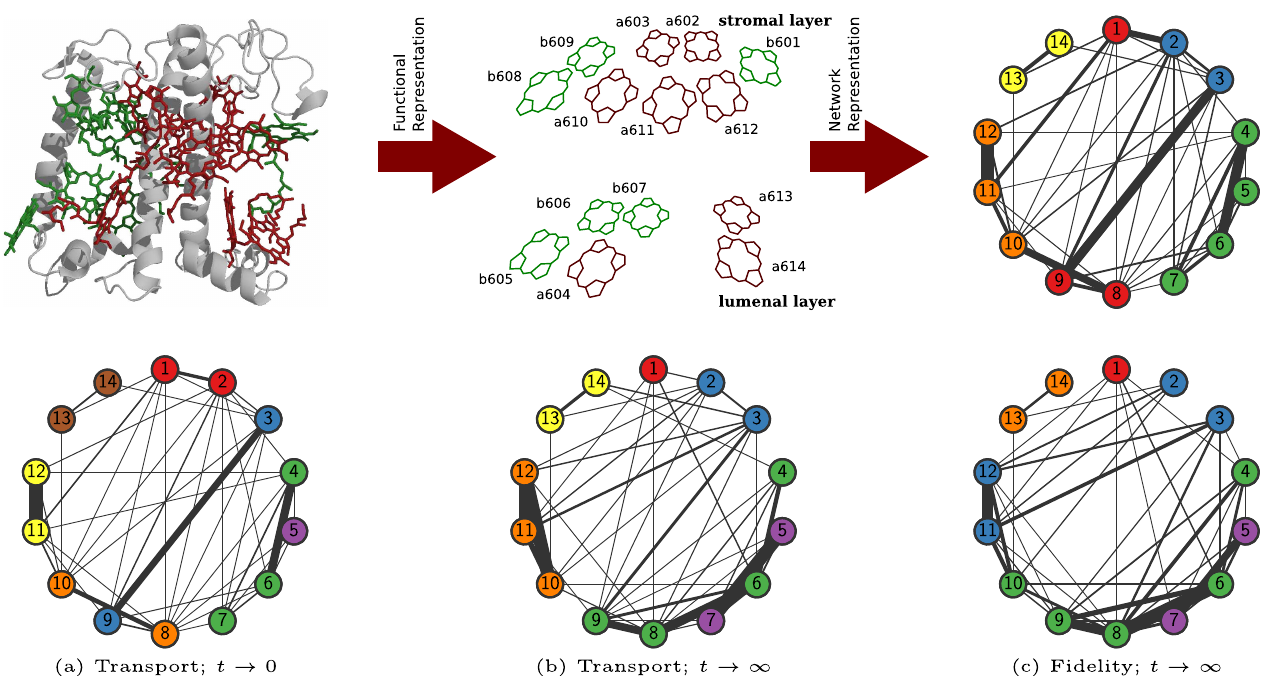
FIG. 4. Light-harvesting complex II (LHCII). (Top, left) Monomeric subunit of the LHCII complex with pigments Chl-a (red) and Chl-b (green) packed in the protein matrix (gray). (Top, center) Schematic representation of Chl-a and Chl-b in the monomeric subunit; here, the labeling follows the usual nomenclature (b601, a602, … ). (Top, right) Network representation of the pigments in circular layout; colors represent the typical partitioning of the pigments into communities. The widths of the links represent the strength of the couplings j H ij j between nodes. Here, the labels maintain only the ordering ( b 601 → 1 ; a 602 → 2 ; … ). (a) – (c) Quantum communities as found by the different quantum community detection methods. Link width denotes the pairwise closeness of the drawn significant attention in the quantum information community.